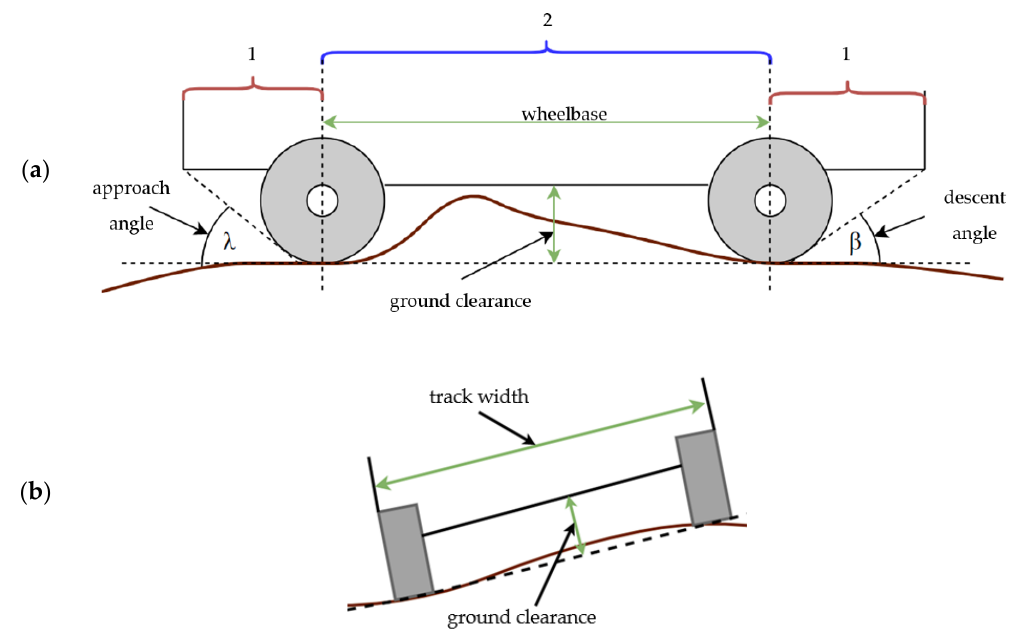
Figure 6. Visualized parameters of the vehicle: ( a ) side view (1—checked by the change of slope; 2—checked by the Python script); and ( b ) rear view.